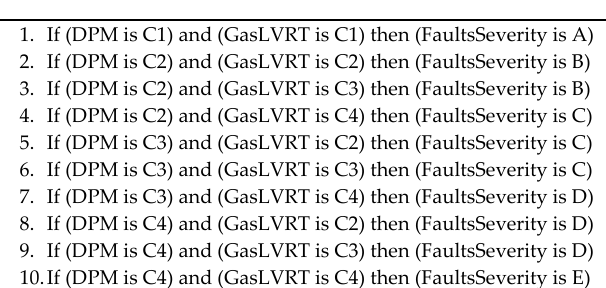
Figure 14. Faults’ severity output membership functions.